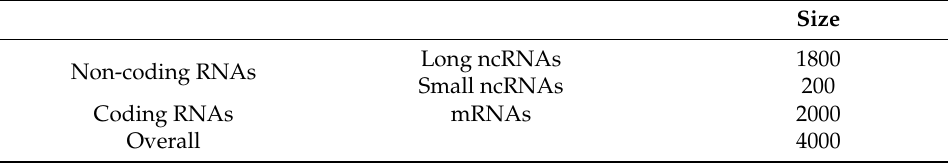
Table 5. Detailed description of the training set